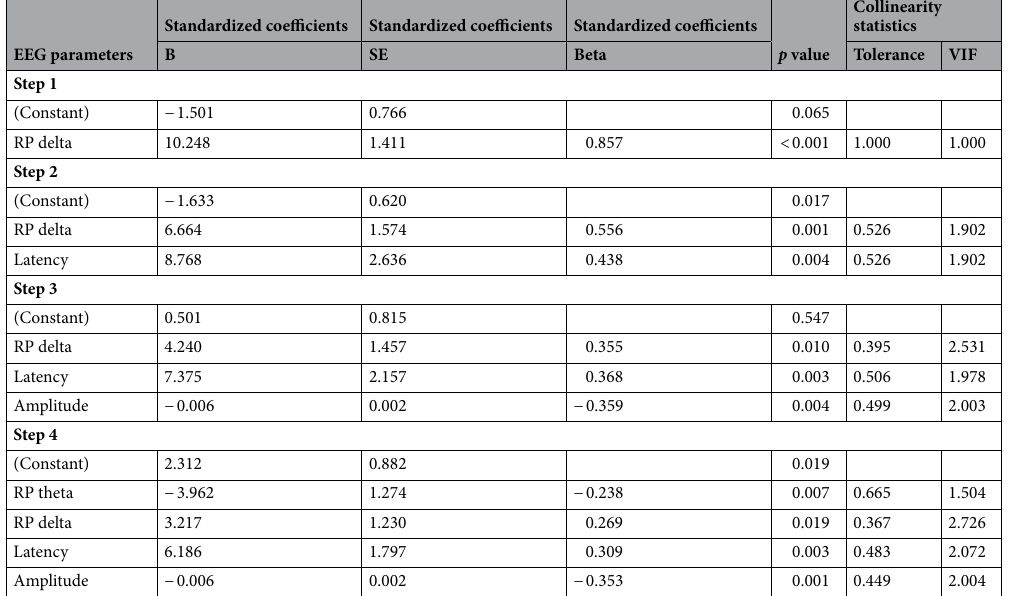
Table 3. Stepwise linear regression analysis using optimal EEG parameters for stroke lesion volume. R 2 = 0.735 for step 1, R 2 = 0.836 for step 2, R 2 = 0.900 for step 3 and R 2 = 0.938 for step 4 with p value < 0.001. Collinearity statistics of variables excluded from the final model are as follows: tolerance = 0.063, VIF = 15.943 for RP alpha and tolerance = 0.067, VIF = 14.870 for DAR. The residual errors of the final model showed normal distribution on a Shapiro–Wilk test ( p value = 0.648). VIF indicates variance inflation